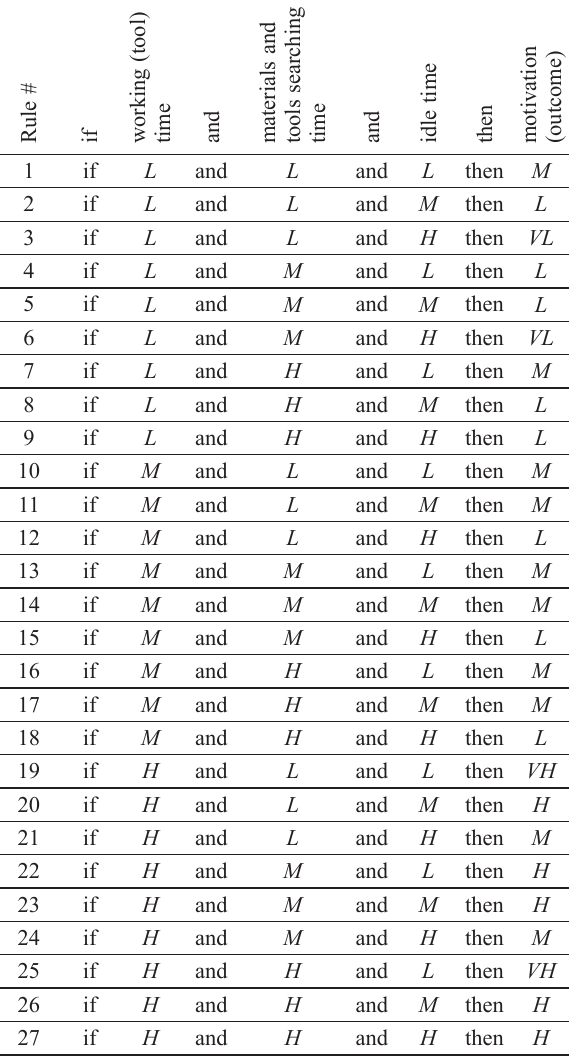
Table 4. A rule set for predicting construction workers’ motivation